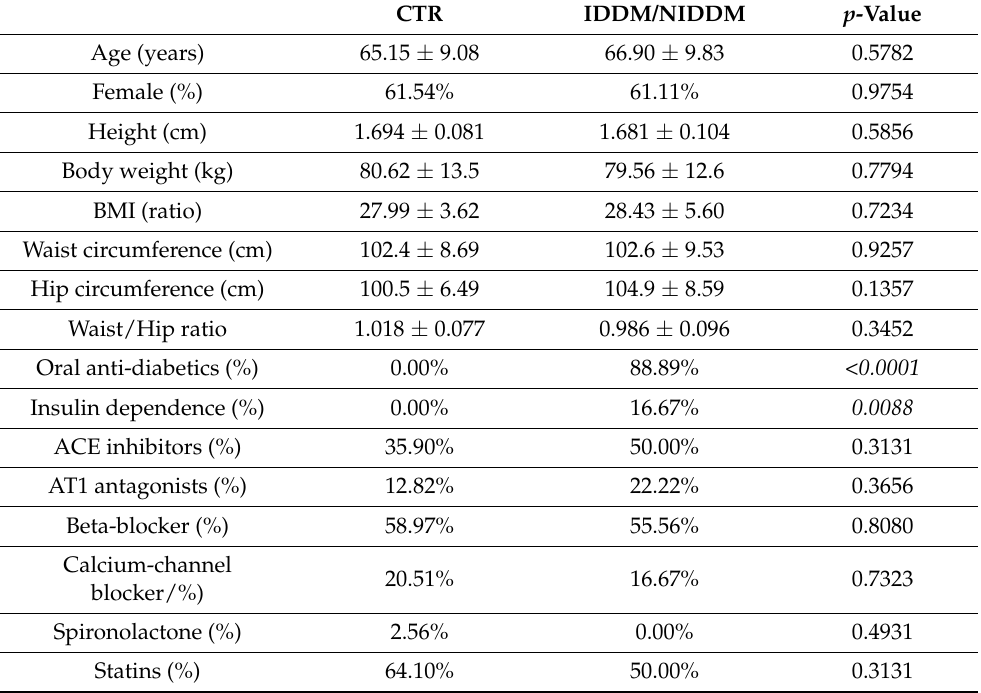
Table 1. Patients’ baseline characteristics. Summary of preoperative patients’ characteristics. Values are expressed as mean ± SD or as percentage (in brackets). Significant changes are displayed in